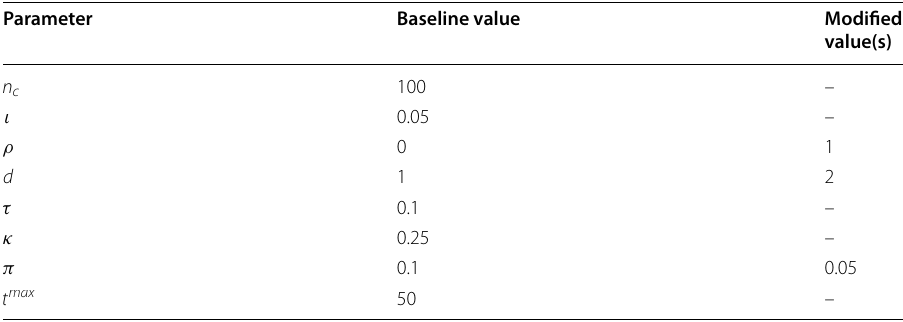
Table 5 Baseline and modified values of parameters used in the simulations